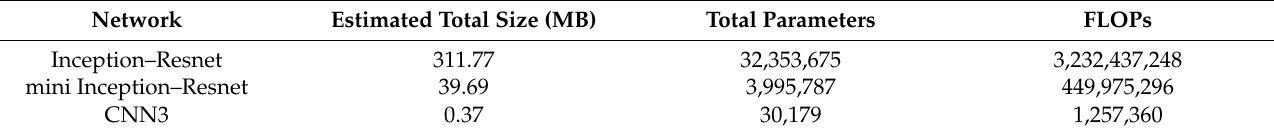
Table 2. Computational complexity of the teacher network vs. the student